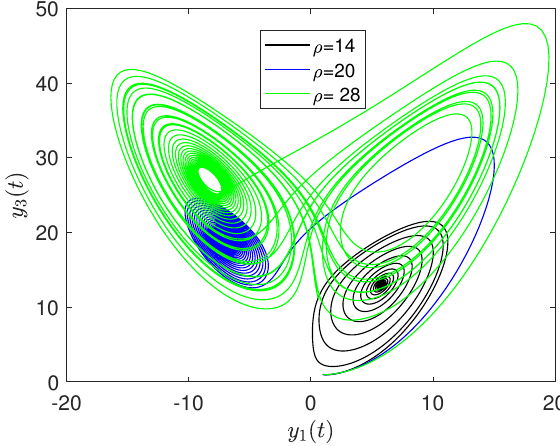
Figure 20. Phase portraits of y 1 and y 3 when varying ρ .